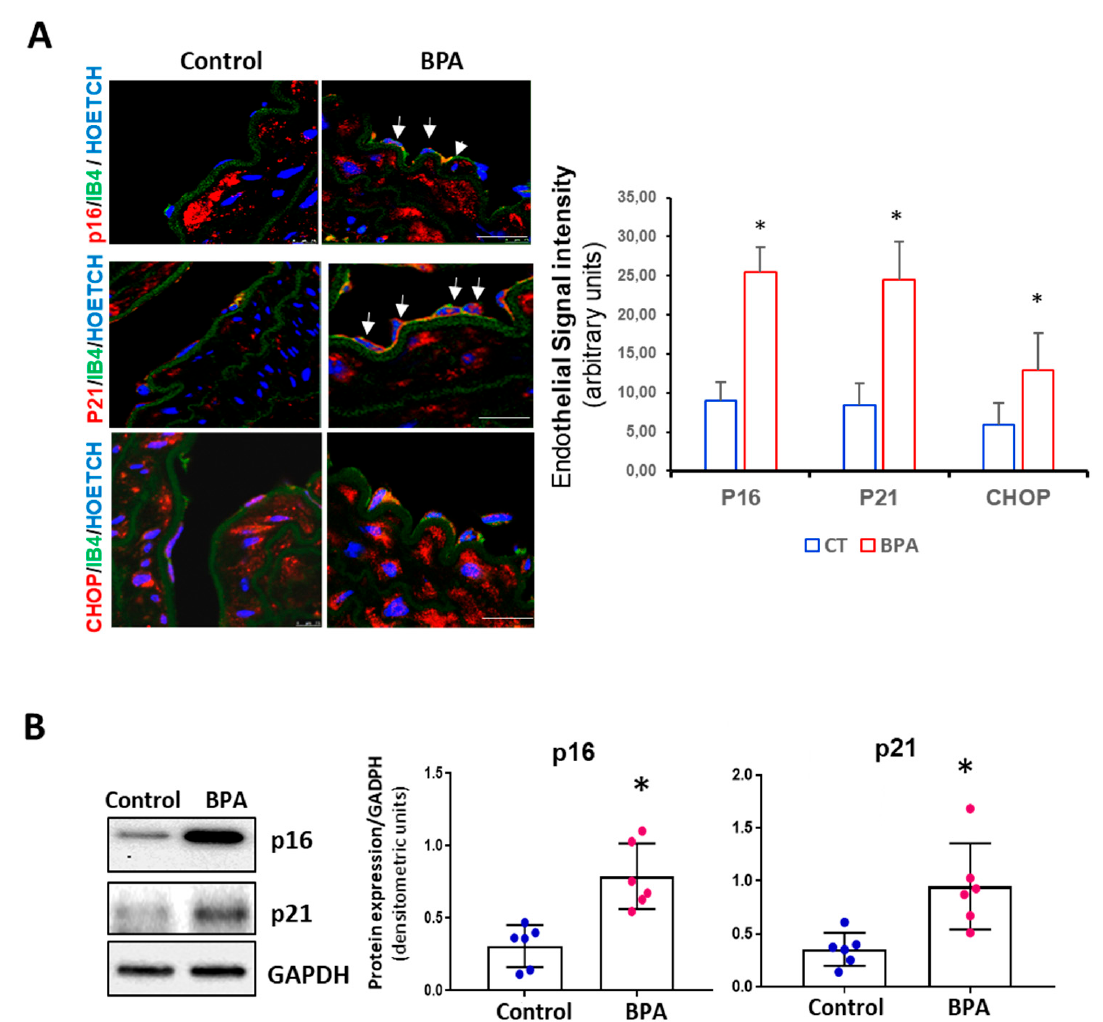
Figure 4. Senescence proteins (p16 and p21) and CHOP expression in BPA-treated-mice aort. Treatment with BPA in drinking water induced notable increases in expression of both the p16, p21, and CHOP proteins. ( A ) Representative confocal images from aorta sections of control and 8-weeks-treated BPA mice followed by immunostaining for p16 (upper panel), p21 (middle panel), and CHOP (lower panel) (red). Endothelium was marked in green with isolectin B4-FITC. Nuclei were labeled with hoechst in blue (n = 8 mice per condition). Scale bar = 60 µ M. ( B ) Immunoblot detection of p16 and p21, in total aorta lysates from CT and 8 weeks BPA-treated mice. GAPDH was used as a loading control. A representative immunoblot is shown. The densitometric analysis is shown below (data are mean ± SD, n = 6 mice per condition) * p < 0.001 vs. CT.